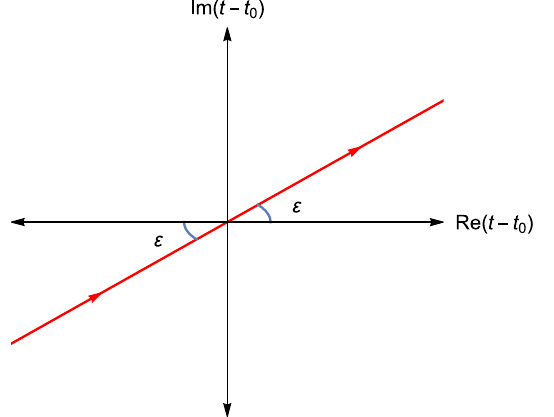
( a ) T 1 : the natural complex time contour that is relevant in the ‘in-out’ formalism.